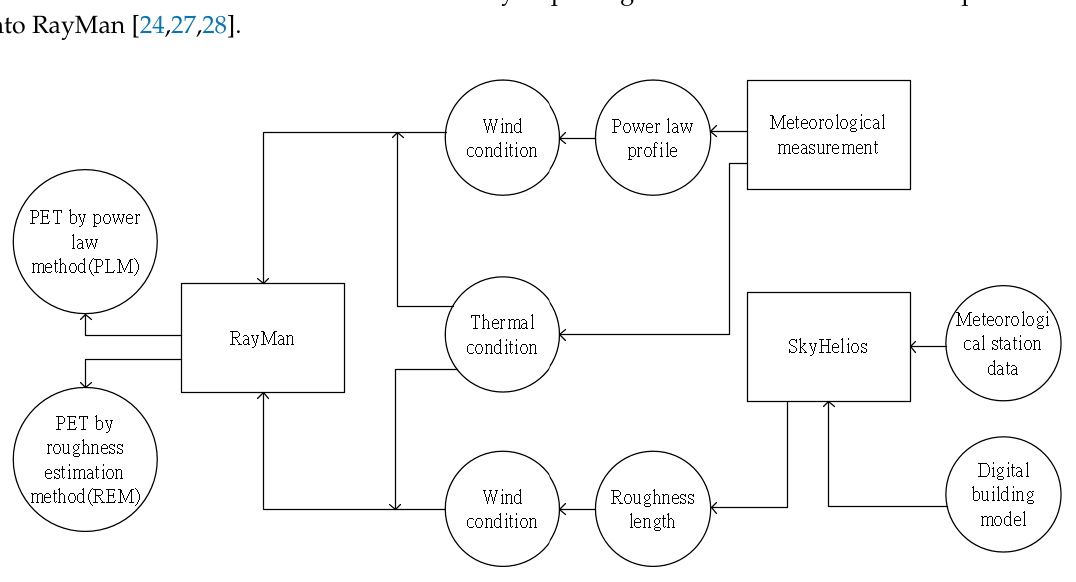
Figure 2. The structure of research.